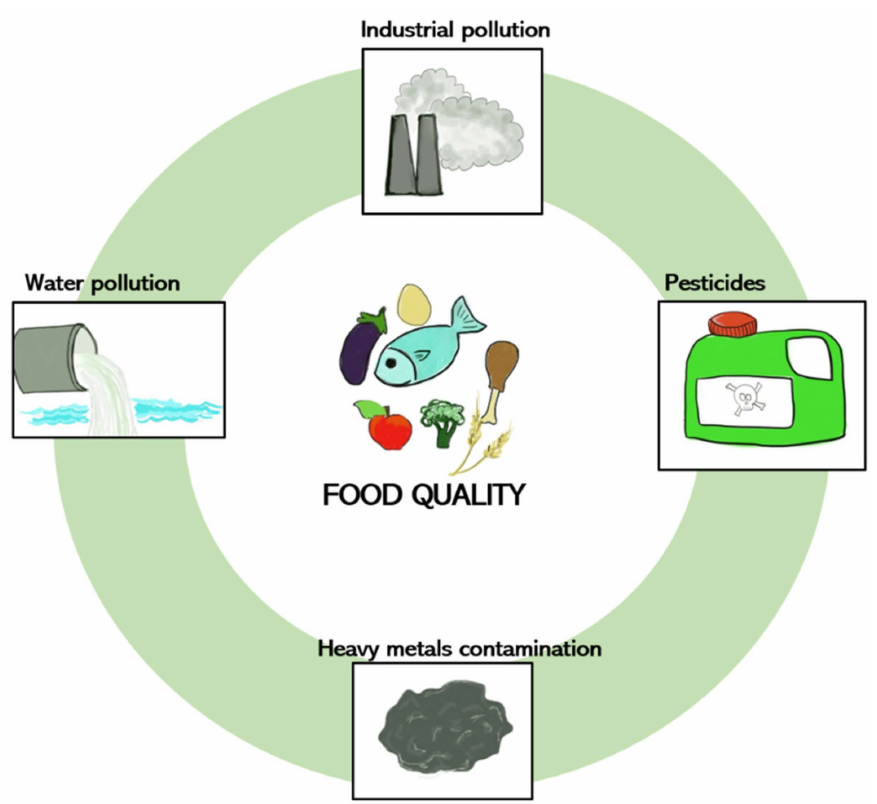
Figure 1. Impact of environmental pollutants on food